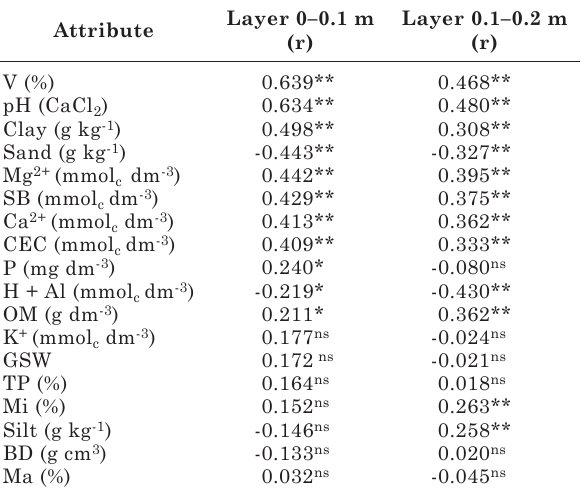
table 2. Correlation coefficients (r) between corn grain yield and soil properties in the 0–0.1 and